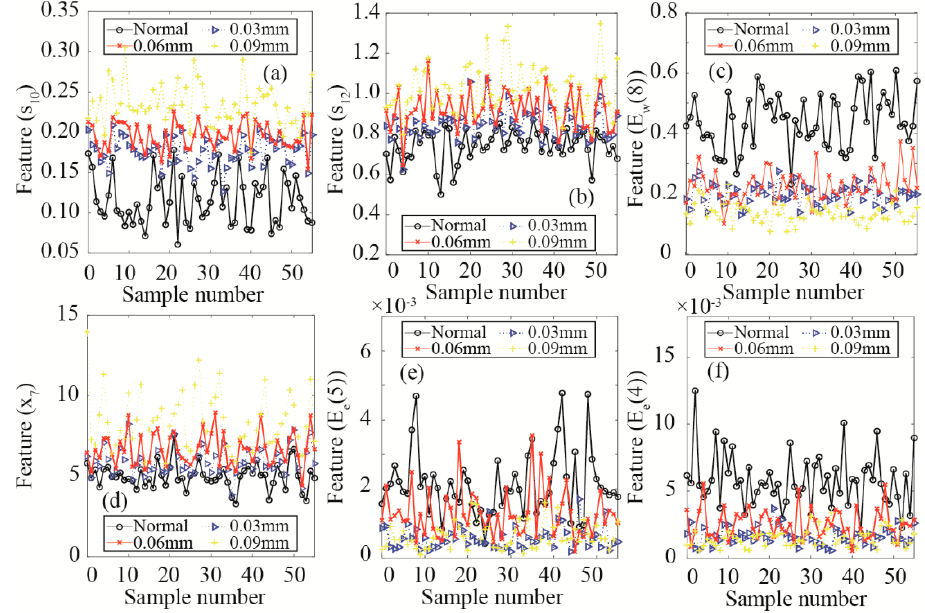
Figure 14. Six sparse feature comparisons under different cases of piston wear.